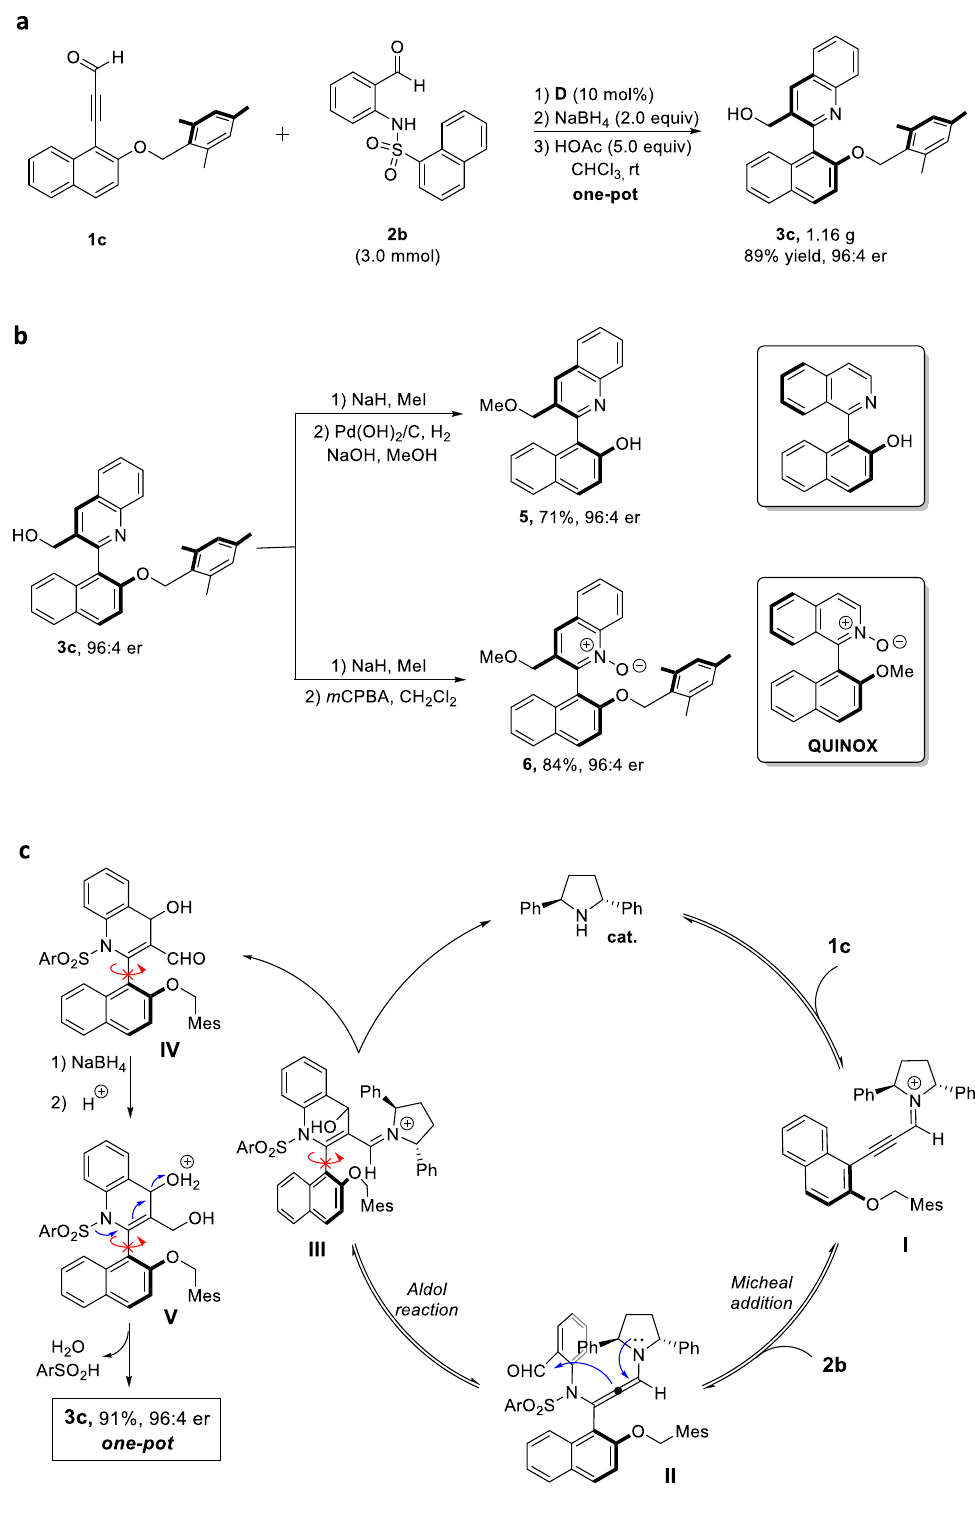
Fig. 4 Gram-scale synthesis and synthetic transformations. a The gram-scale synthesis of 3c . b The synthetic transformations of 3c . c Plausible